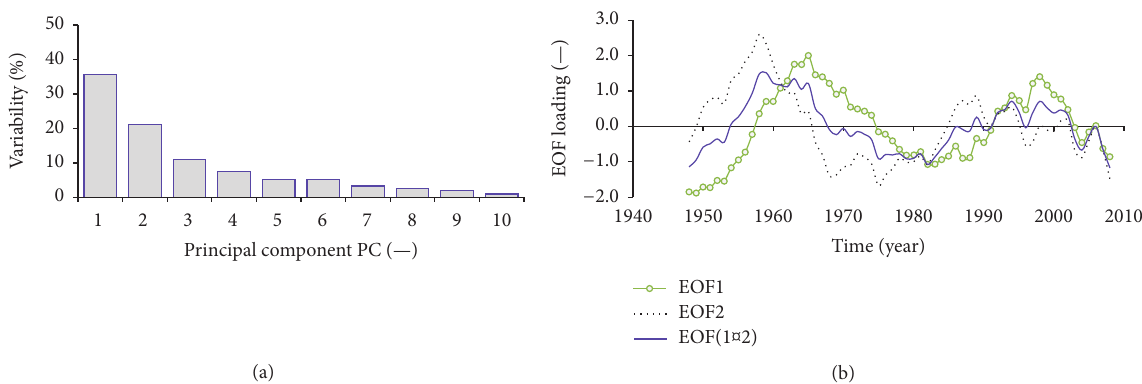
Figure 4: (a) Percentage of variability explained in the rainfall and (b) the first (EOF1) and second (EOF2) dominant EOF factor loadings. EOF (1 ¤ 2) denotes the average of EOF1 and